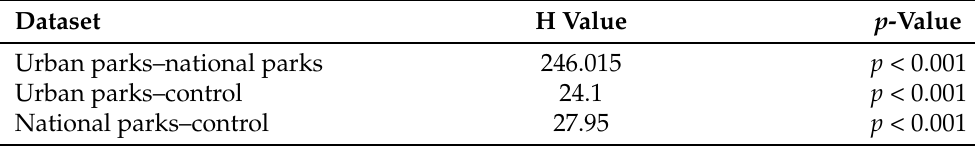
Table 6. Results of the calculation of the Kruskal–Wallis H